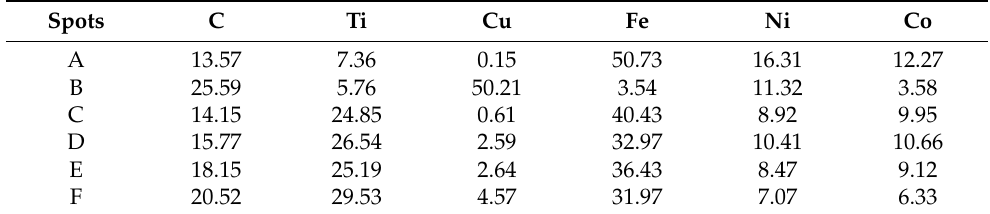
Figure 9. Microstructure and line scan analysis spectrum of the Kovar/Cu/Ti/Ht250 interface at different welding temperatures: ( a ) 940 °C; ( b ) 1000 °C; ( c ) 1060 °C. Table 4. Component content of each point in Figure 9 (at